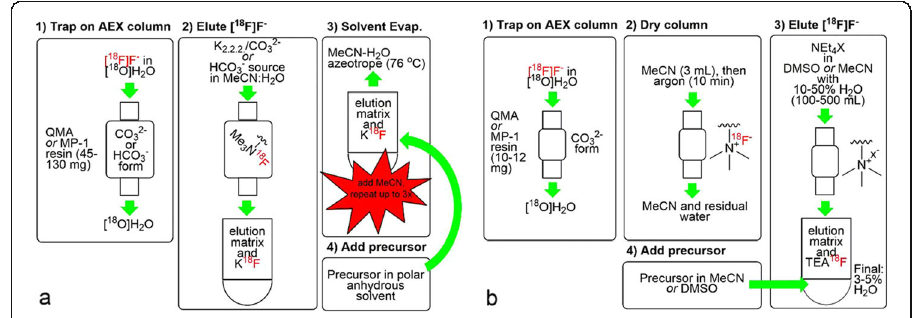
Fig. 1 Traditional ( a ) and “ non-anhydrous, minimally-basic ” NAMB ( b ) approaches to the extraction, preparation and use of [ 18 F]F − for the manufacture of PET radiopharmaceuticals. X − = HCO 3 − , ClO 4 − , or OTs − .